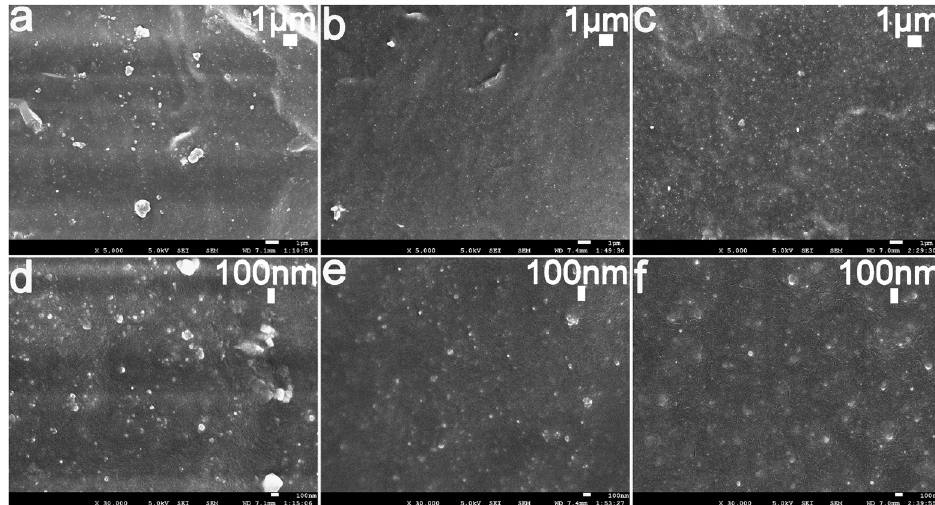
Figure 2: SEM micrographs of IR/silica/CB vulcanizates: 0 phr ATD for SC - 1 ( a and d ) , 1.5 phr ATD for SC - 2 ( b and e ) , and 3.0 phr ATD for SC - 3 ( c and f ) . Table 3: Mechanical properties of modi fi ed IR/silica/CB vulcanizates with ATD Samples Hardness ( Shore A